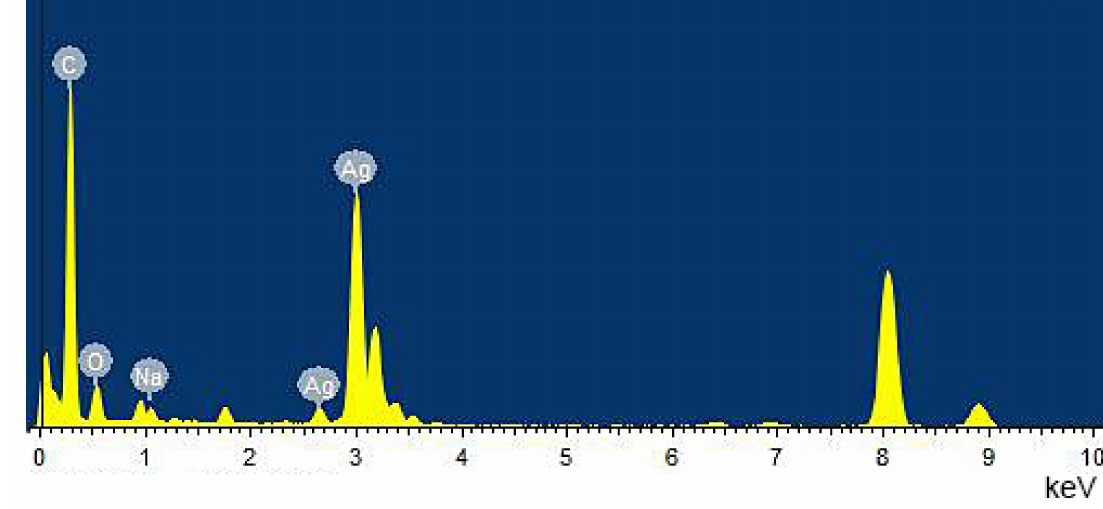
Figure 4. Energy-dispersive X-ray (EDS) spectrum of CMC-SNs. The peak at 8 keV is the copper element in the copper plate used in TEM sample preparation.